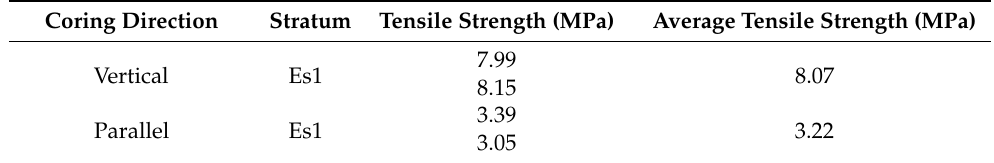
Table 4. Shale tensile strength test results in vertical/parallel bedding directions.